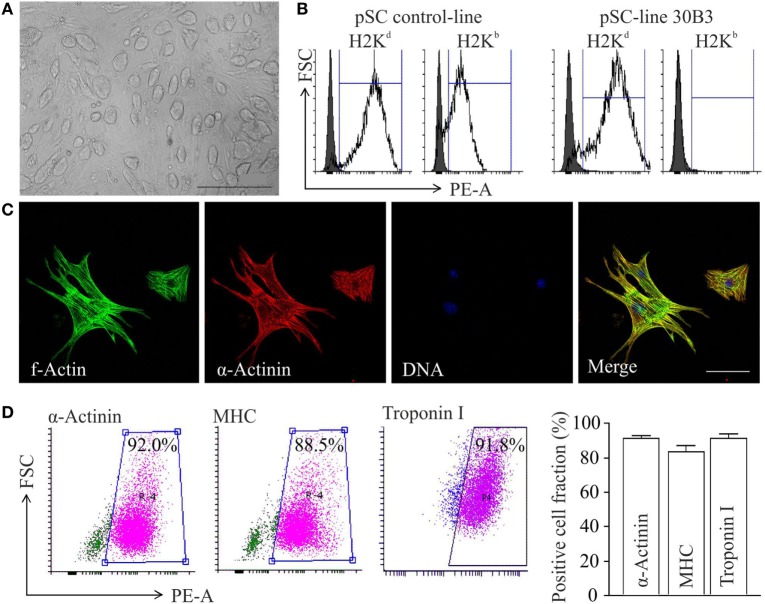
Differentiation of major histocompatibility complex (MHC)-I-homozygous parthenogenetic stem cells (pSCs) into cardiomyocytes. (A) Morphology of undifferentiated pSC colonies at passage 21 cultured on murine embryonic fibroblasts. Scale bar: 500 µm. (B) FACS analysis of MHC class I molecules on unselected derivatives of an MHC-heterologous control pSC-line (left panel) and on the MHC-homologous pSC30B3-line used in this study (right panel), both generated from oocytes derived from the MHC-heterologous B6D2F1 mouse-strain. (C) Confocal microscopy of pSC-derived cardiomyocytes. Scale bars: 20 µm. (D) FACS-analysis of cardiomyocyte-specific proteins in pSC-derived cardiomyocytes after 7 days of chemical purification with G418 (MHC: myosin heavy chain). Left panels: Representative scatter blots. Right panel: Summary of the flow cytometry data (n = 4–12/group).